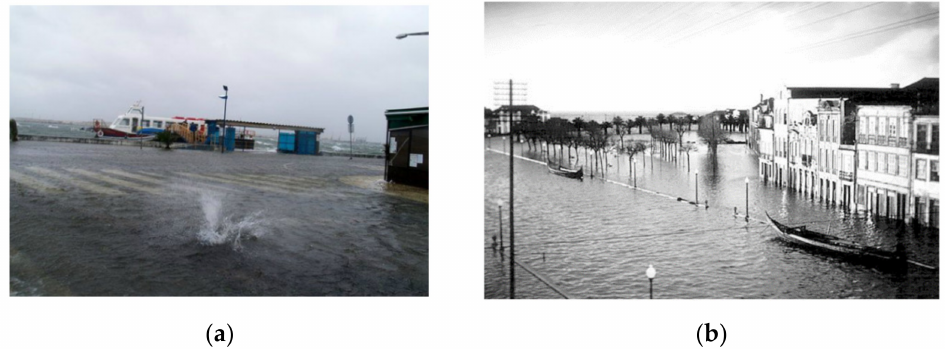
Figure 2. Floods in ( a ) S. Jacinto (www.bombeirosnovos.pt/node/107, accessed on 1 December 2021) and ( b ) the Aveiro historical center (http://territoriopositivo.blogspot.com/2019/, accessed